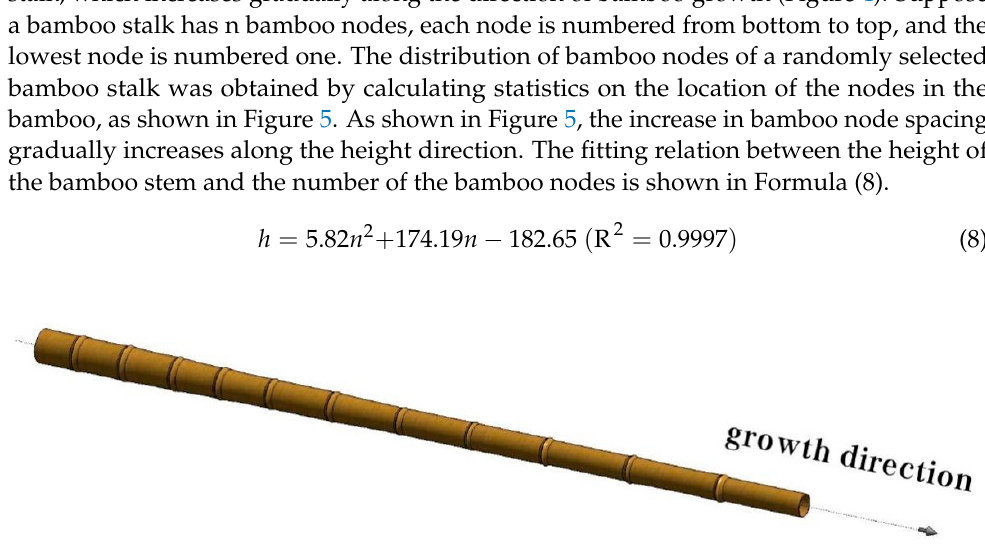
Figure 3. Typical load-displacement curve of the specimen.